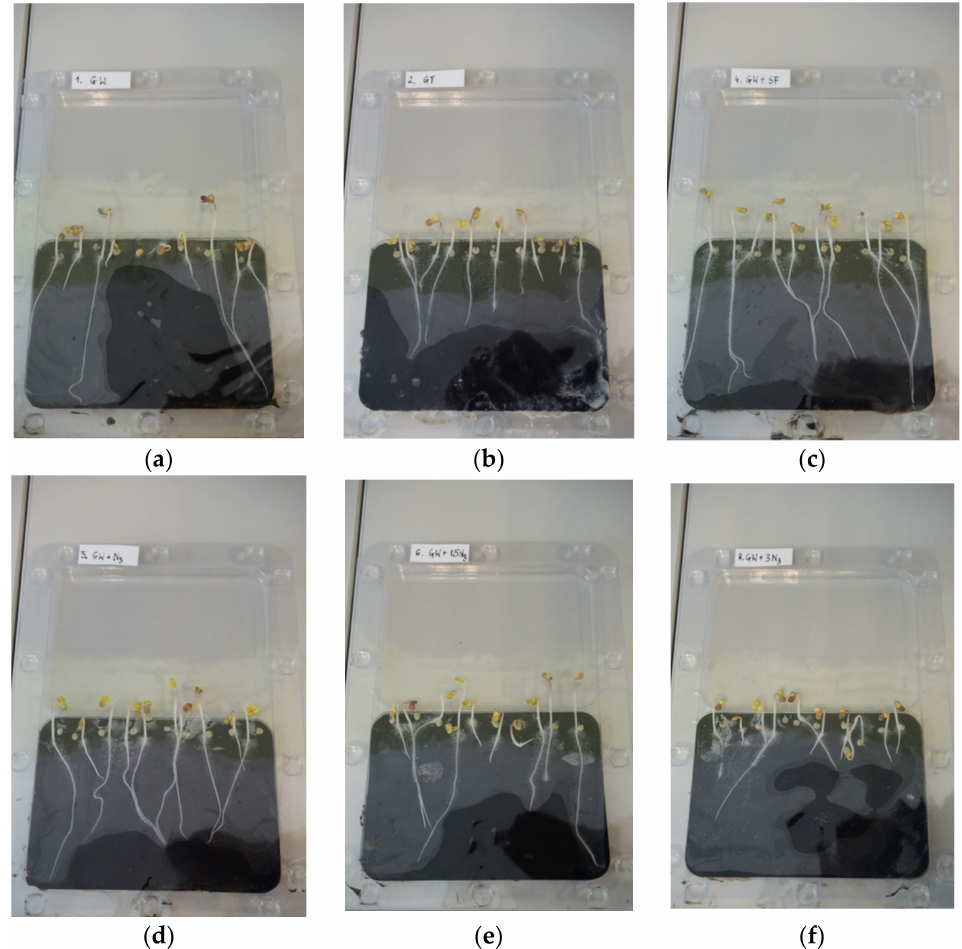
Figure 5. Cassette cultivation–view after 72 h: ( a ) root growth in test C1; ( b ) root growth in test L; ( c ) root growth in the C2; ( d ) root growth in test C4; ( e ) root growth in test C5; ( f ) root growth in test C7–visible variable germination and root growth of white mustard Sinapis alba L. Explanations: test symbols according to Table